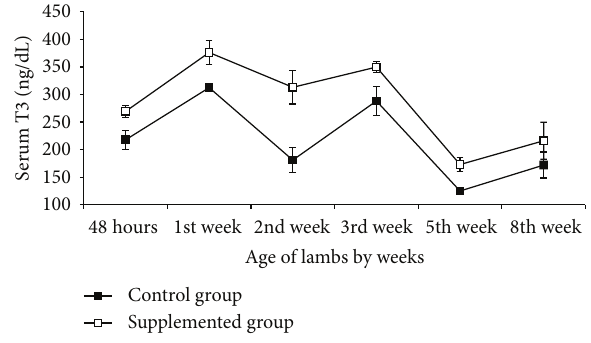
Figure4:SerumT3concentration(mean ± SEM)ofnewbornlambs from Se supplemented and control